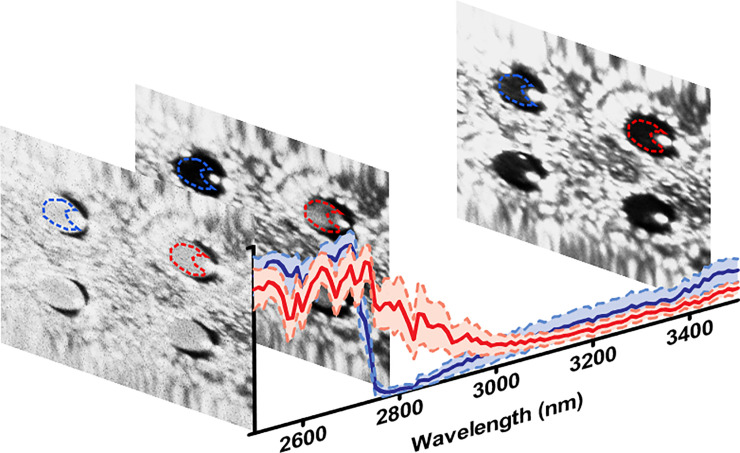
3D hyperspectral data cube.Visual representation of three example images from the NCI imager forming a 3D hypercube. The corresponding ‘Raw’ spectra of the mean of each ROI is also shown. The blue spectrum represents a healthy sample, and the red a traumatised sample treated with Triton X. A region of interest was obtained for each insert to collect the spectra from each sample, removing the spectral contribution of the internal reflection saturating the detector. This can be observed in the right-hand side of each well within the images.